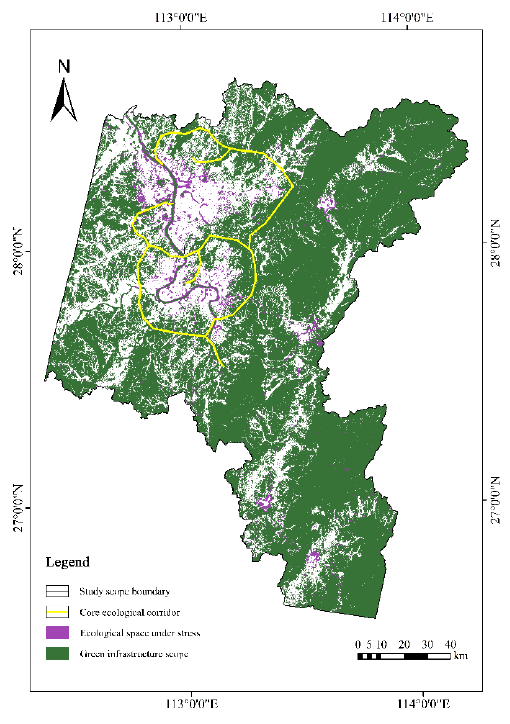
Figure 5. Stressed green infrastructure in the “urban plan ning control” scenario in 2030.